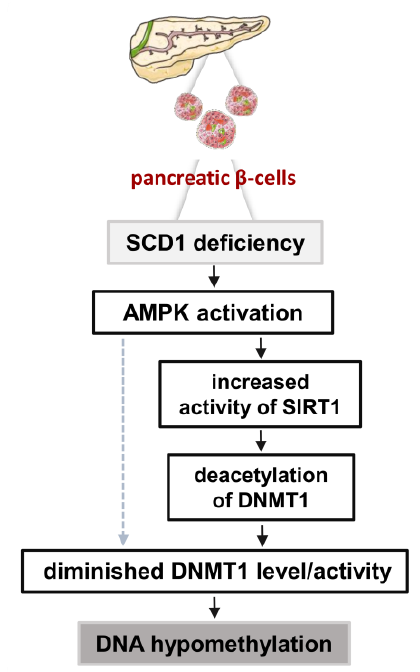
Figure 7. Impact of SCD1 deficiency on gDNA methylation levels in pancreatic β -cells. SCD1 downregulation in INS-1E cells results in the activation of AMPK, upregulation of SIRT1, and promotion of DNMT1 deacetylation. AMPK activation and SIRT1-dependent changes in DNMT1 acetylation status trigger the loss of DNMT1 function and stability, consequently leading to gDNA hypomethylation. The dashed arrow indicates the potential direct (independent of SIRT1) control of gDNA methylation levels by AMPK.